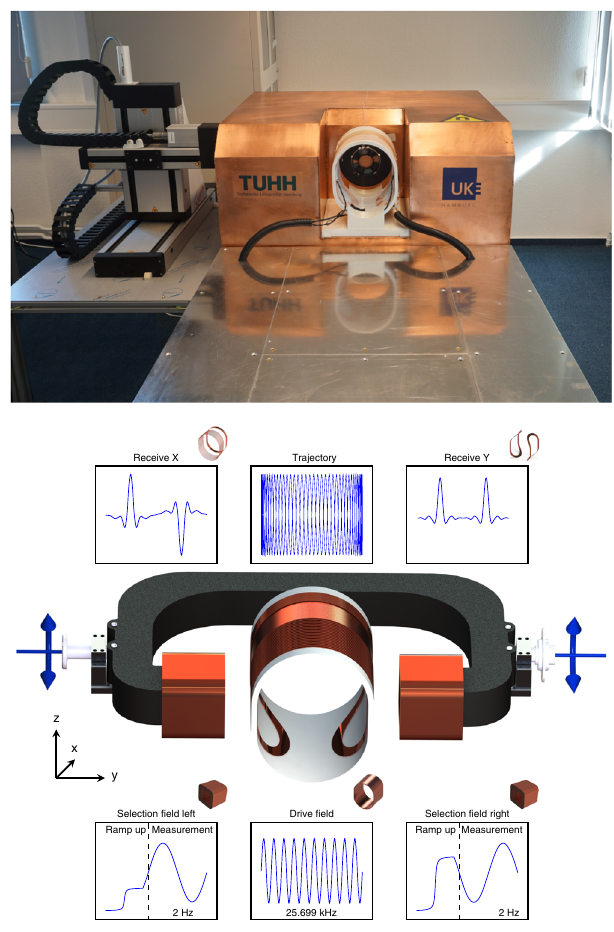
Fig. 1 Implementation and concept of the presented system. Picture of the developed MPI head scanner. The system-calibration robot is placed to the left of the imager (top). Scanner concept (bottom). The central coil is used as a drive- fi eld generator with a frequency of 25.699 kHz and an amplitude of 6 mT μ 0 − 1 . The cross section is formed by two half circles connected by straight parts forming an ellipsoid-like shape. The selection- fi eld coils are driven by sinusoidal currents with opposite signs superimposed by an offset current. This generates an FFP oscillating on the y -axis in-between the selection- fi eld coils. The superposition of the drive- fi eld and the selection- fi eld generates a Cartesian like FFP trajectory covering an FOV within the xy -plane of 100 × 140 mm 2 . The particle response is received by dedicated coils in x -direction and y